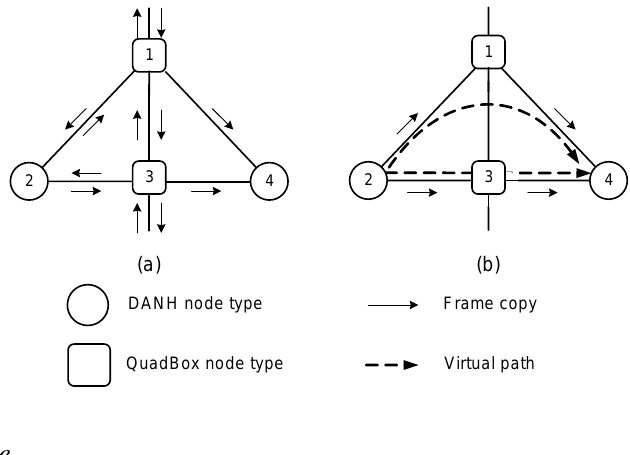
Figure 1. A network example shows the main idea of the dual virtual paths (DVP) algorithm compared to the standard high-availability seamless redundancy (HSR) protocol. ( a ) Node 2 sending a single frame to Node 4 using the standard HSR protocol; ( b ) Node 2 sending a single frame to Node 4 using the DVP algorithm.